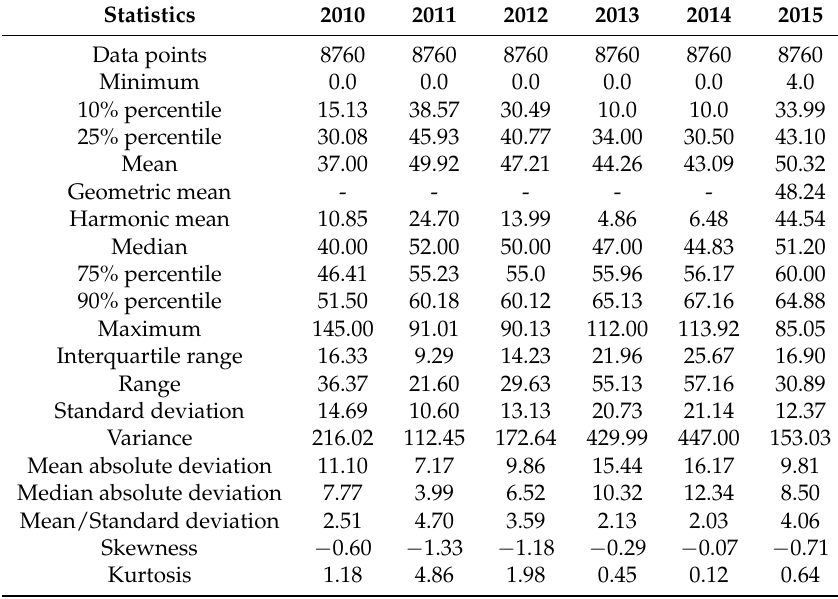
Table 1. Summary statistics of the Spanish electricity prices ( e /MWh) of